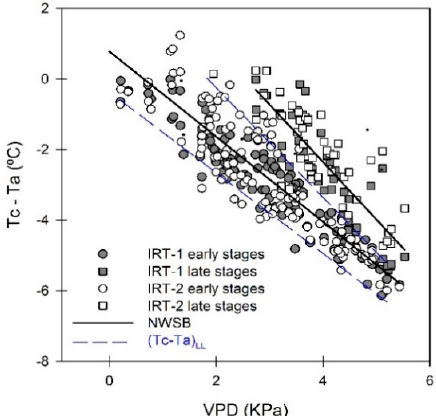
Figure 6. Seasonal response of T c − T a to VPD in mature almond trees, using data from two infrared temperature sensors (IRT-1 and IRT-2). The linear regression equations for the non-water stress baselines (NWSB) at the early (DOY 106-190) and late (DOY 191-221) growth stages were y = − 1.248 x + 0.922 and y = − 2.011 x + 5.518, respectively. The regression equations for the lower limit (T c − T a ) LL at the same dates were y = − 1.088x − 0.413 and y = − 1.553 x + 2.860.